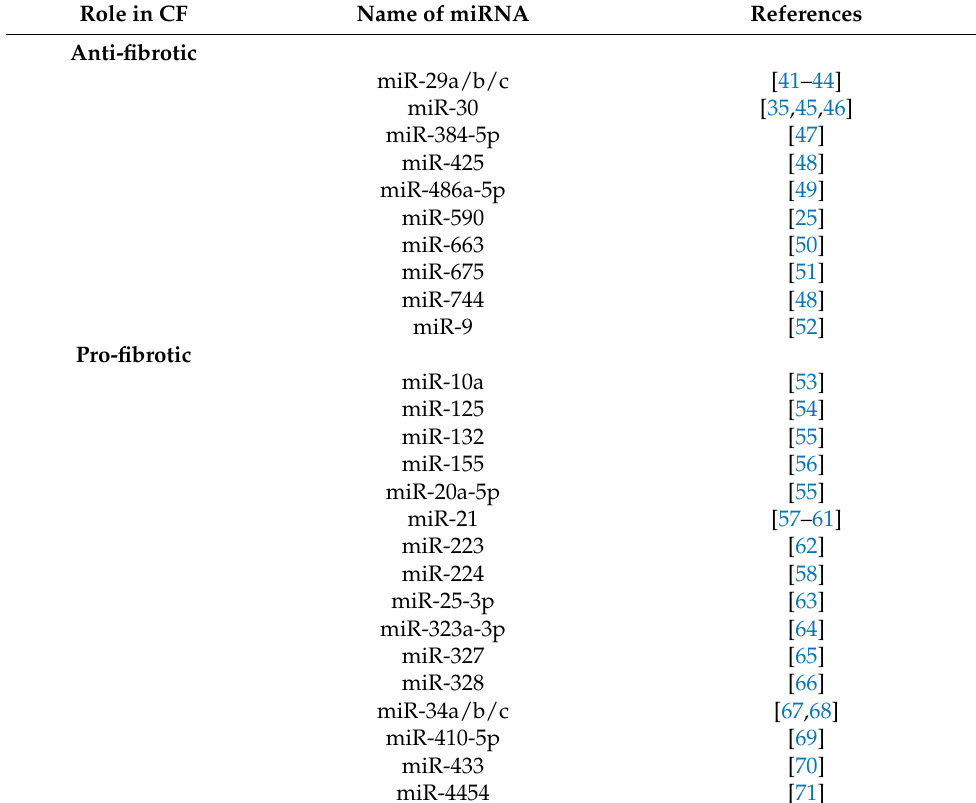
Table 1. Cont. Role in